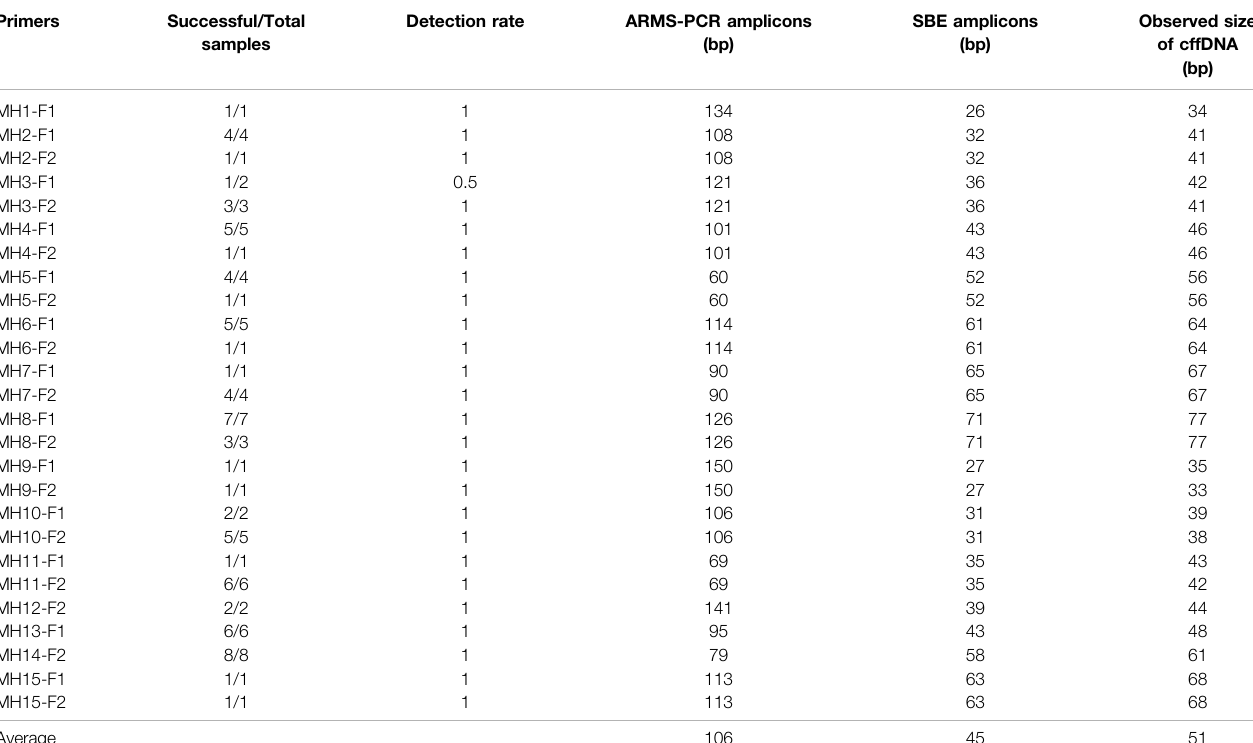
TABLE 2 | Primer information of informative markers and detected fetal DNA size. Primers Successful/Total